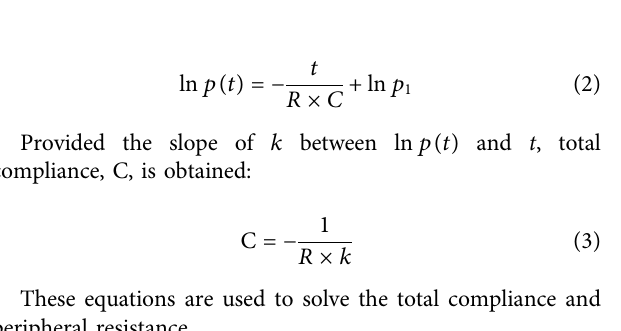
Frontiers in Physiology |